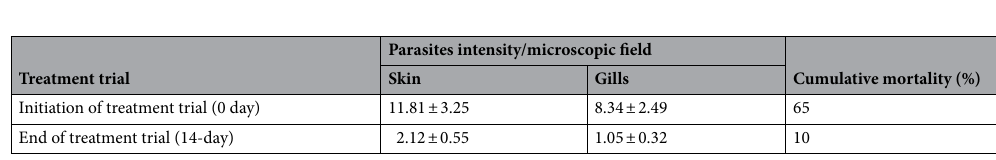
Table 2. Treatment trial of mixed protozoal infection in Liza carinata . The degree of protozoan intensity was calculated as previously mentioned in Table 1.